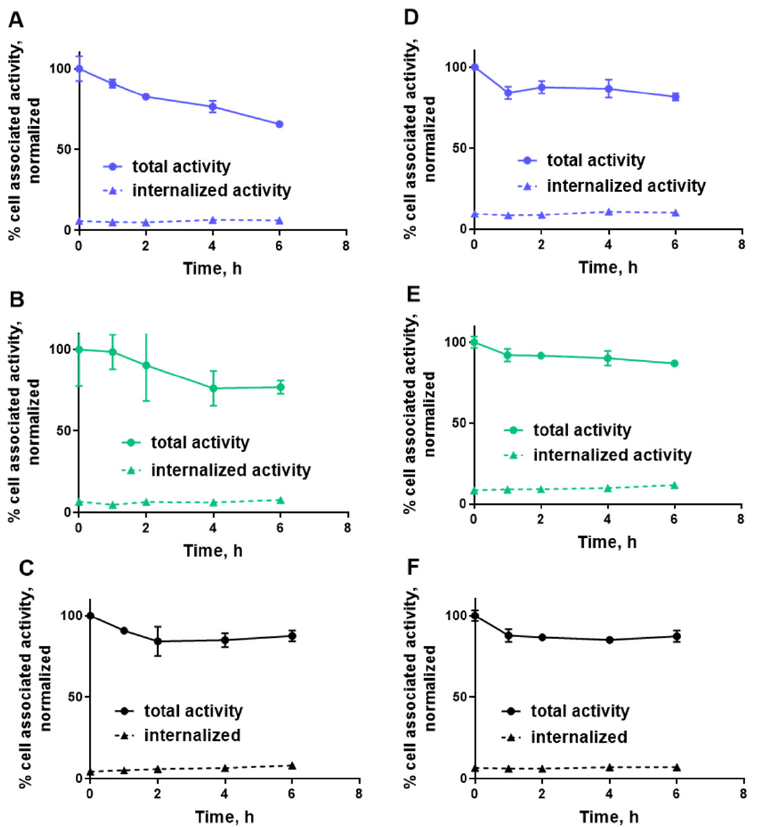
Figure 6. Normalized cellular retention of ( A , D ) [ 99m Tc]Tc-ZHER2:41071, ( B , E ) [ 99m Tc]Tc-ZHER2:V2 and ( C , F ) [ 99m Tc]Tc-ZHER2:2395 to HER2-expressing SKOV3 ( A – C ) and BT-474 ( D – F ) cell-lines. The data are presented as an average ( n = 3) and SD. Error bars are not seen because they are smaller than point symbols.